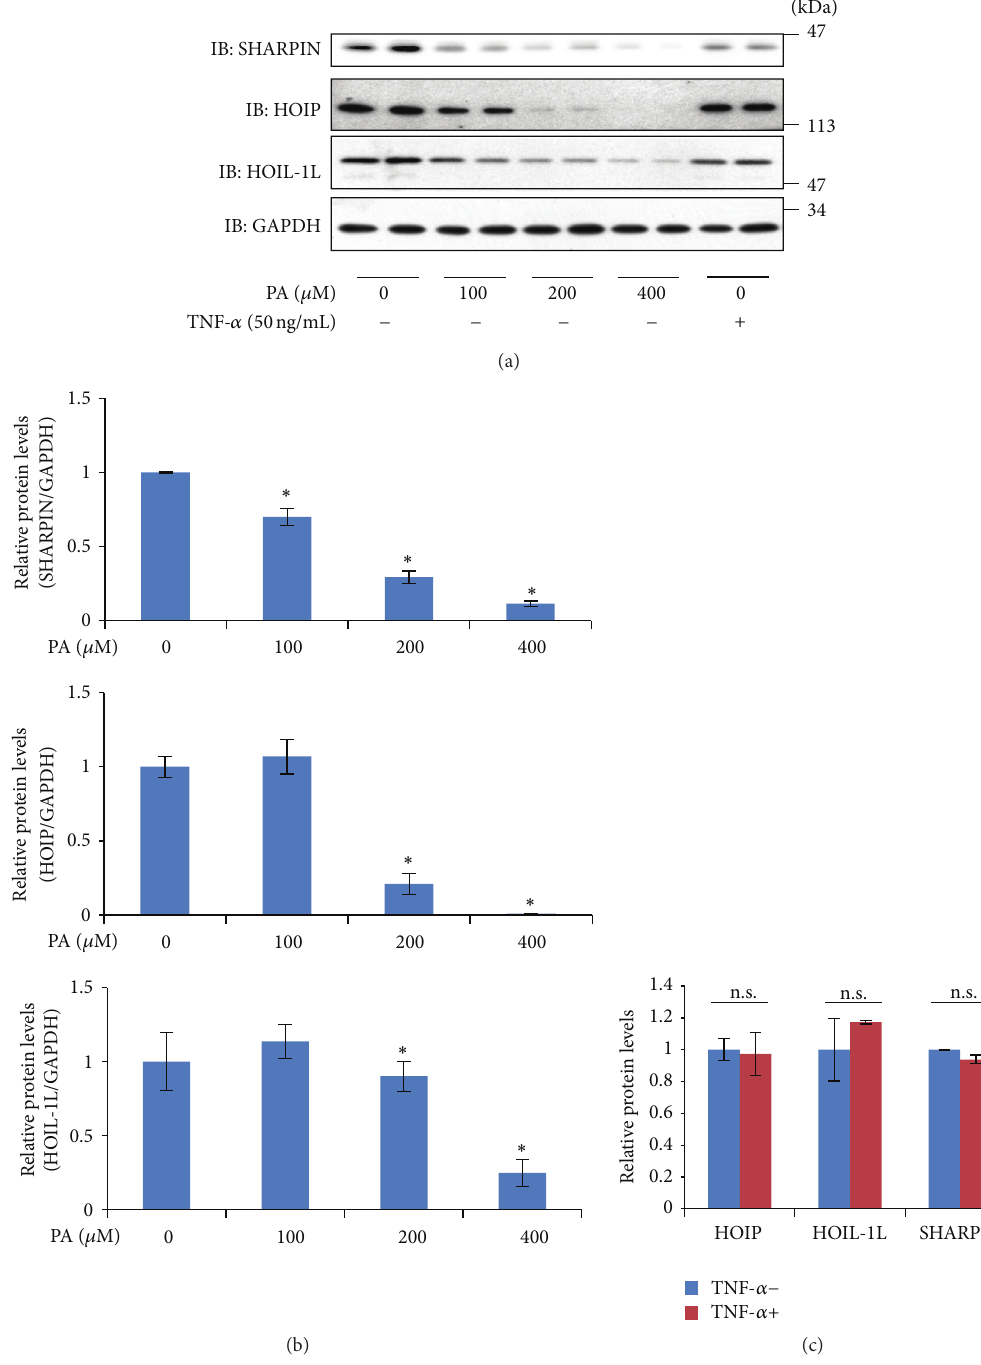
Figure 4: HepG2 cells were incubated for 24 hr in the presence or absence of PA or TNF- 𝛼 . (a) Cell lysates were harvested in lysis buffer and expressions of HOIP, HOIL-1L, and SHARPIN were determined by immunoblotting using the corresponding antibodies. (b) The expression changes in LUBAC components with palmitate stimulation are shown in the bar graph. (c) The expression changes in LUBAC components with TNF stimulation are presented as quantitative data. These data are representative of three to five independent experiments, and results are shown as means ± S.E.M. ∗ 𝑝 < 0.05